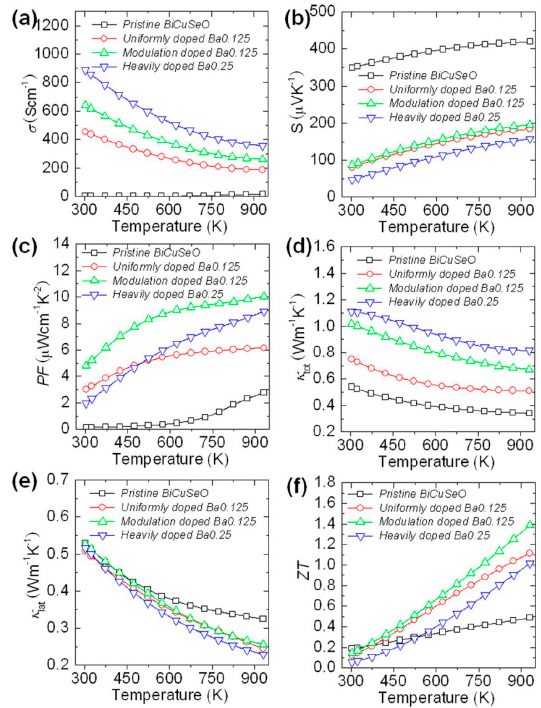
Figure 11. Thermoelectric properties of pristine BiCuSeO, uniformly doped Bi 0.875 Ba 0.125 CuSeO, modulation doping, and heavily Ba doped Bi 0.75 Ba 0.25 CuSeO. ( a ) The electrical conductivity; ( b ) the Seebeck coefficient; ( c ) the power factor; ( d ) total thermal conductivity; ( e ) lattice thermal conductivity; and ( f ) the figure of merit ZT. Reproduced (adapted) with permission from Reference [8]. Copyright 2014, American Chemical Society.